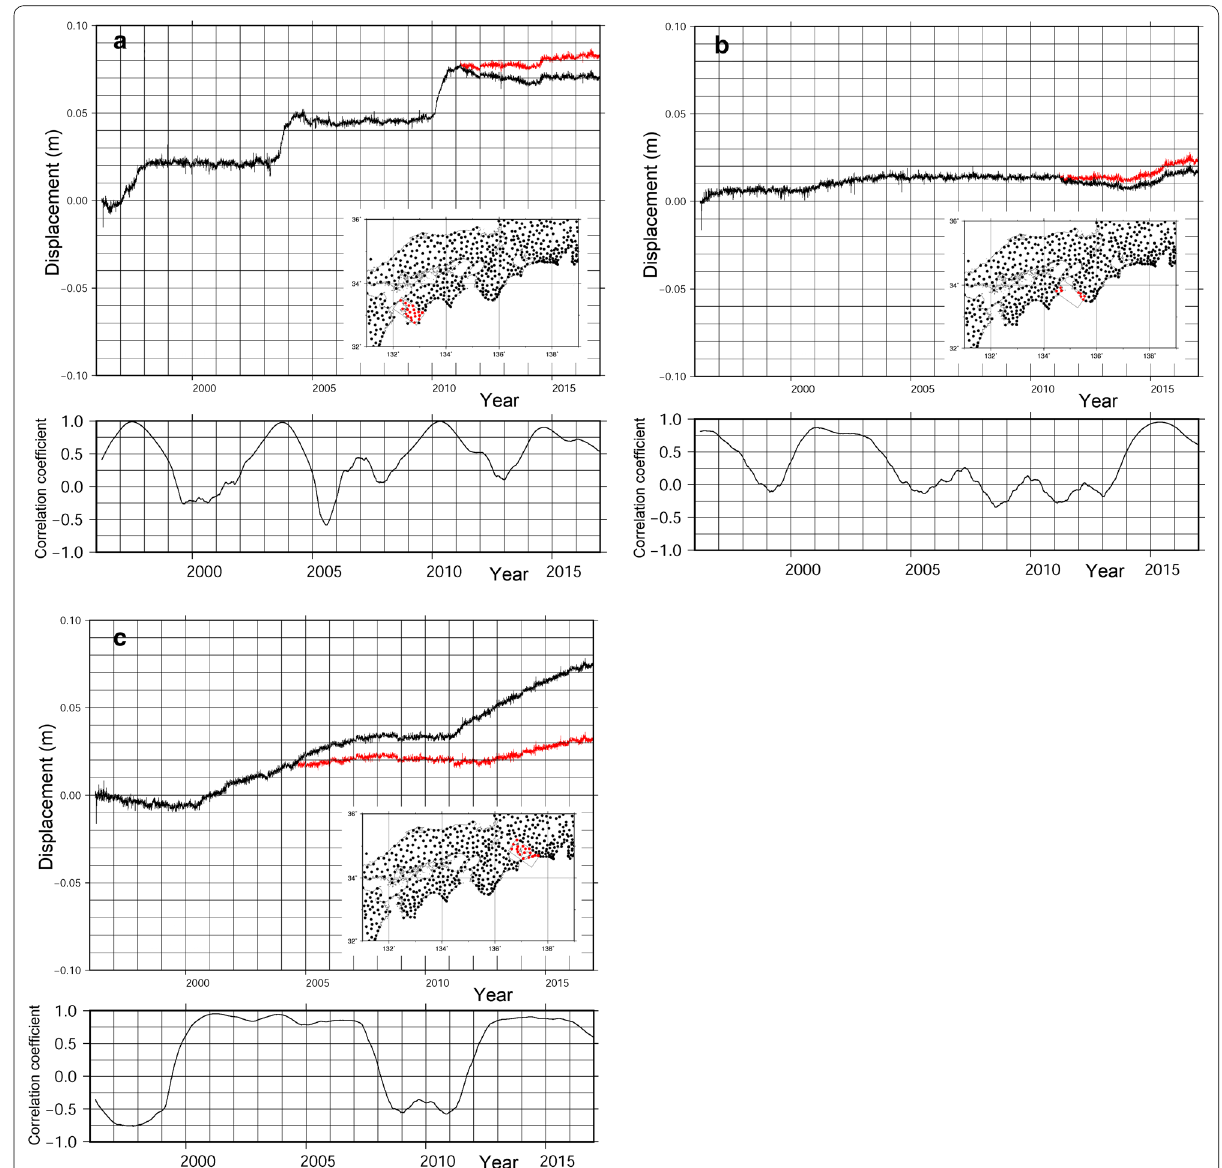
Fig. 4 Displacements in the direction S55°E (top) and correlation coefficients between the displacement and the ramp function at select points (bottom). a Bungo Channel and westernmost Shikoku. b Kii Channel. c Tokai region. Displacement is the mean of displacements of stations (red dots) within the 100 km 50 km rectangle on the inset map. Displacement curves after correcting for postseismic displacement are shown in ×